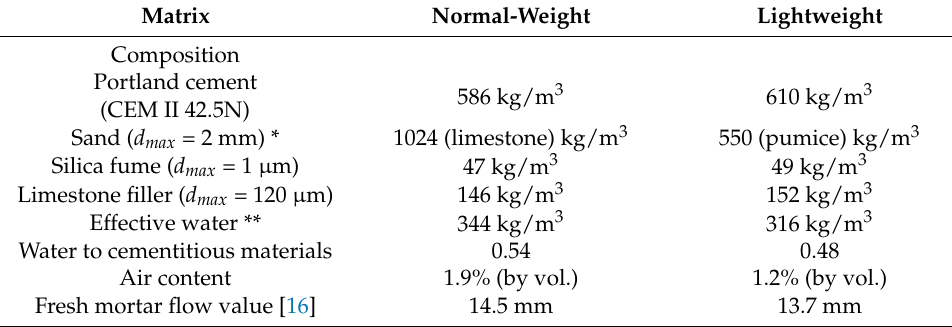
Table 1. Composition and physical properties of matrices. Matrix Normal-Weight Lightweight